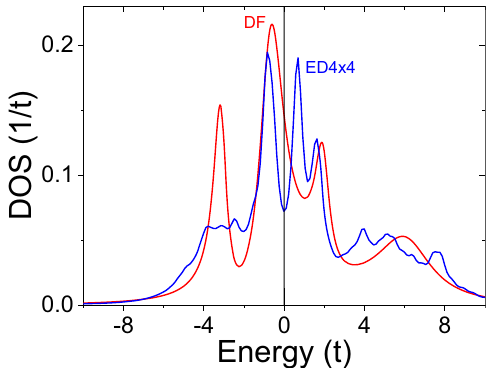
Fig. 6 Pseudogap formation. Density of states for dual fermion plaquette perturbation (DF) in comparison with exact diagonalisa- tion (ED) for 4 × 4 periodic cluster for U = 5.56, t 0 t 0 = t ¼ (cid:1) 0 : 3 , μ 0 = 0.6 and μ = 1.3, and β =